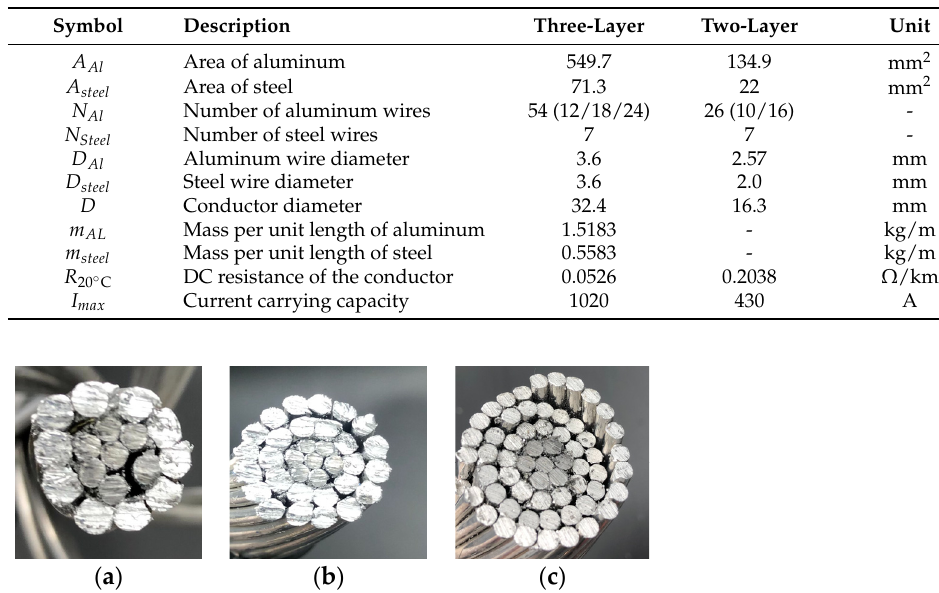
Figure 2. Cross section of the analyzed ACSR conductors. ( a ) Single-layer 7/10 conductor. ( b ) Two- layers 7/26 conductor. ( c ) Three-layer 7/54 conductor.